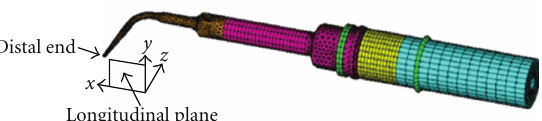
Figure 4: ANSYS model of the ultrasonic